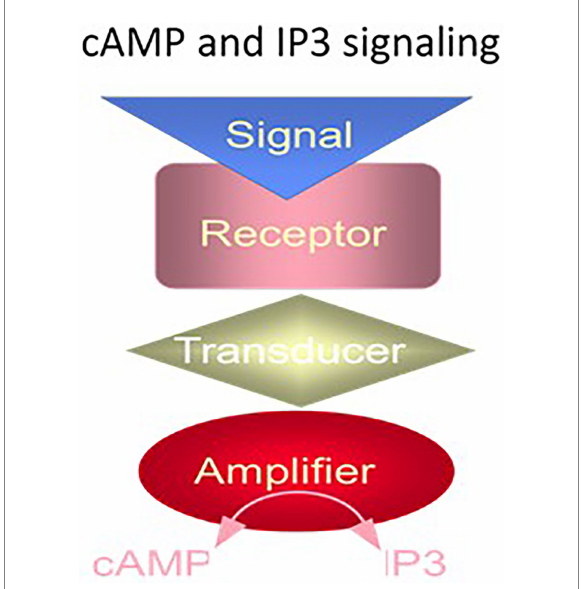
FIGURE 1 The cyclic AMP and IP3 signaling systems. The cyclic AMP and IP3 signaling systems consist of three separate components: hormone receptor, transducer (G protein) and amplifier adenylate cyclase (for cyclic AMP signaling) or phospholipase C (for IP3 signaling). (Modified from Sharma and Duda,